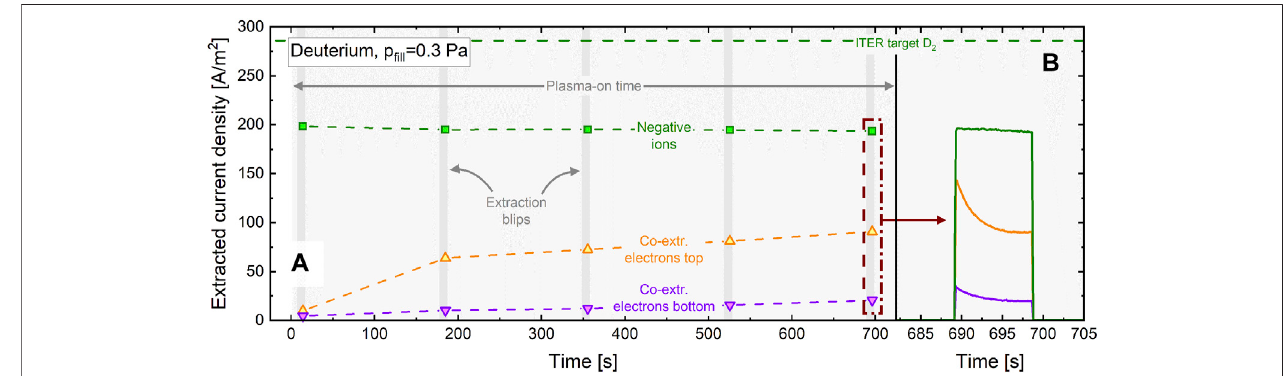
FIGURE 12 | Current densities of extracted negative ions and co-extracted electrons for the top and bottom segment during a 700 s pulse in deuterium. (A) Averaged values for the fi ve extraction blips. (B) Time traces measured during the very last extraction blip.